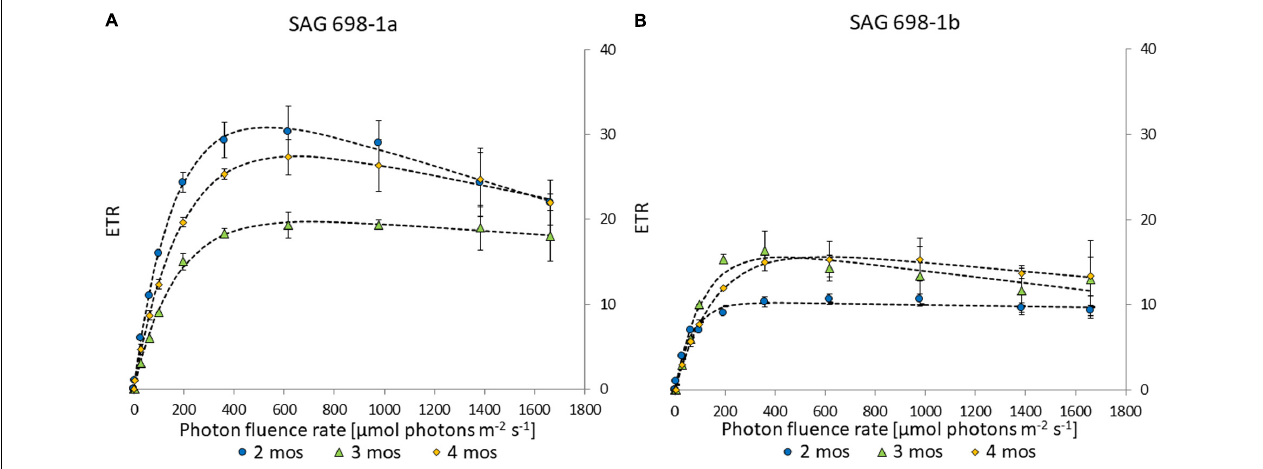
FIGURE 5 | Electron transport rate – irradiance curve of (A) SAG 698-1a and (B) SAG 698-1b. 2-months old cultures (